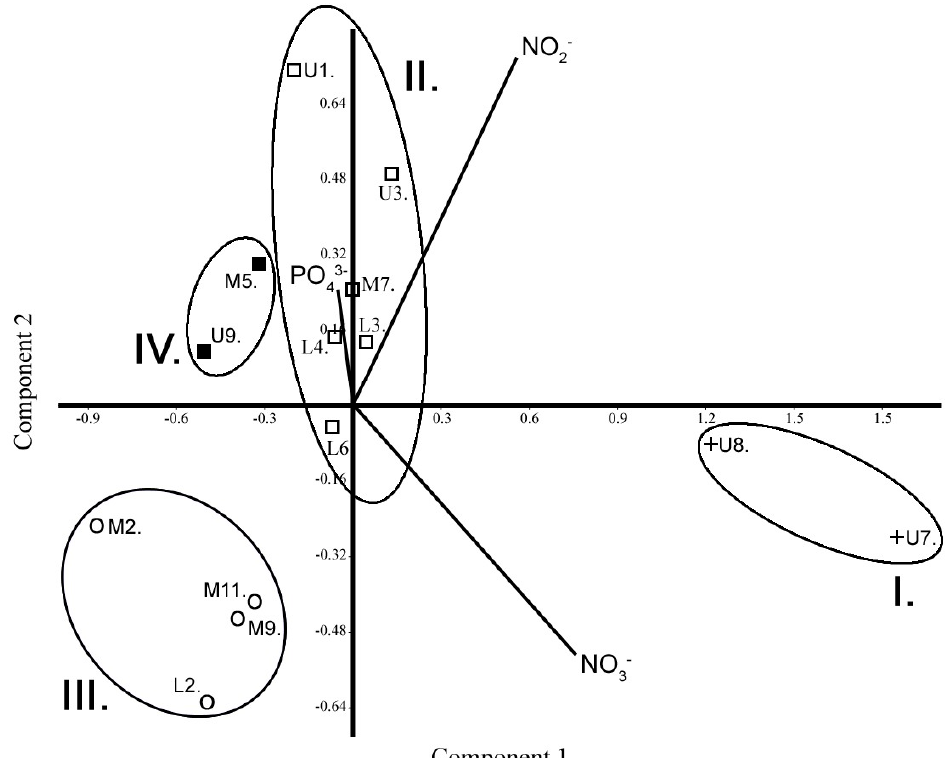
Figure 4. The results for the autumn period of the principal component analysis of the physical and chemical variables measured at the sampling points. Group I: cross (+). Group II: empty square ( □ ). Group III: empty circle (o). Group IV: full square ( ■ ). Upper Area: U1 − U9; Middle Area: M1 − M11; Lower Area: L1 − L6.